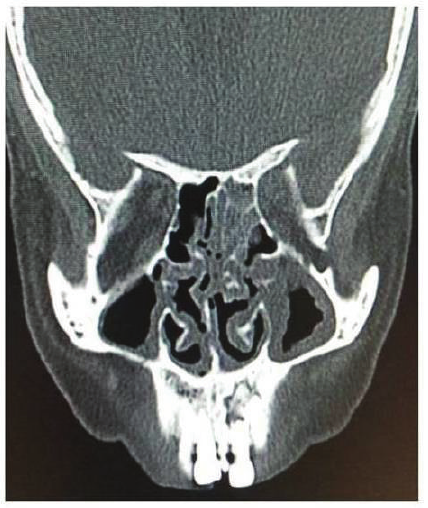
Figure 3: CT scan images shows thickening of mucosa and opacifi- cation of the